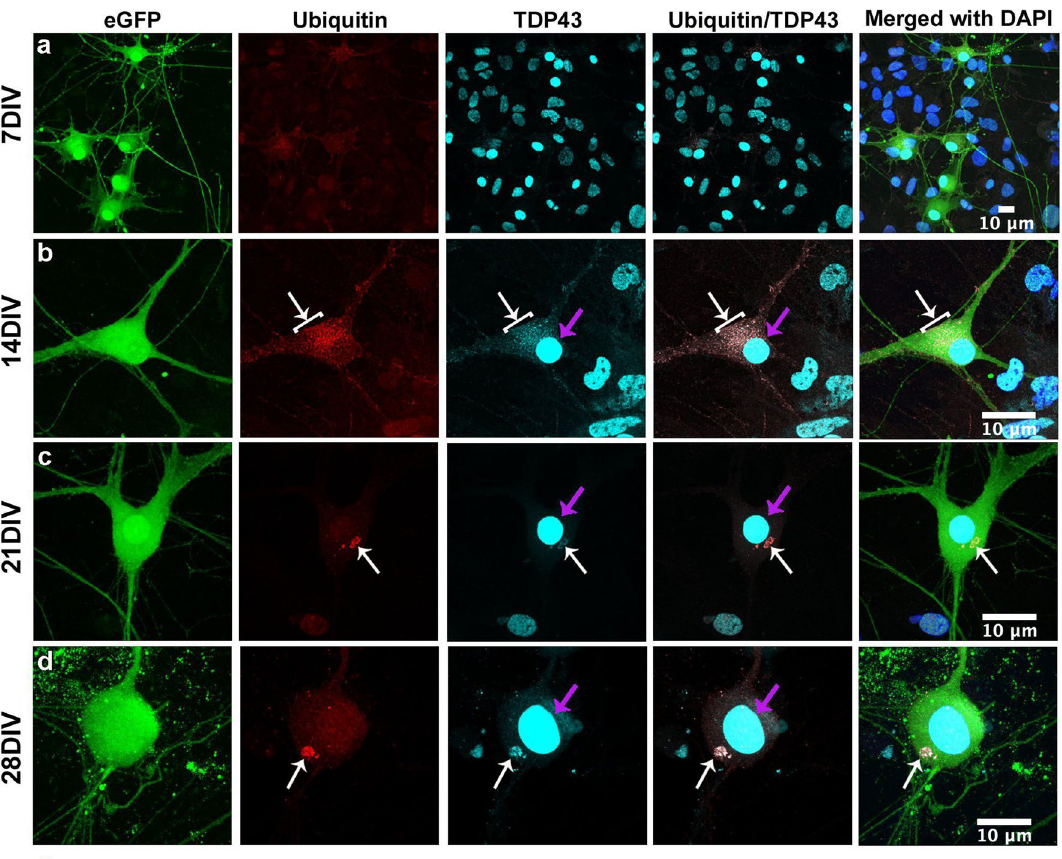
Figure 1. Immunocytochemical analysis of mutant MNs. Mutant MNs show the presence of both nuclear TDP-43 (pink arrows) and co-localized cytoplasmic TDP-43/ubiquitin aggregates (white arrows) at 7,14, 21 and 28 DIV ( a – d ). Massive dendritic pruning and axonal retraction in mutant MNs were observed at 28 DIV ( d ), indicating the onset of MNs degeneration. No disease phenotype was manifested at 7DIV in mutant cells ( a ). The MN nuclei can be identified from the large regions of TDP-43